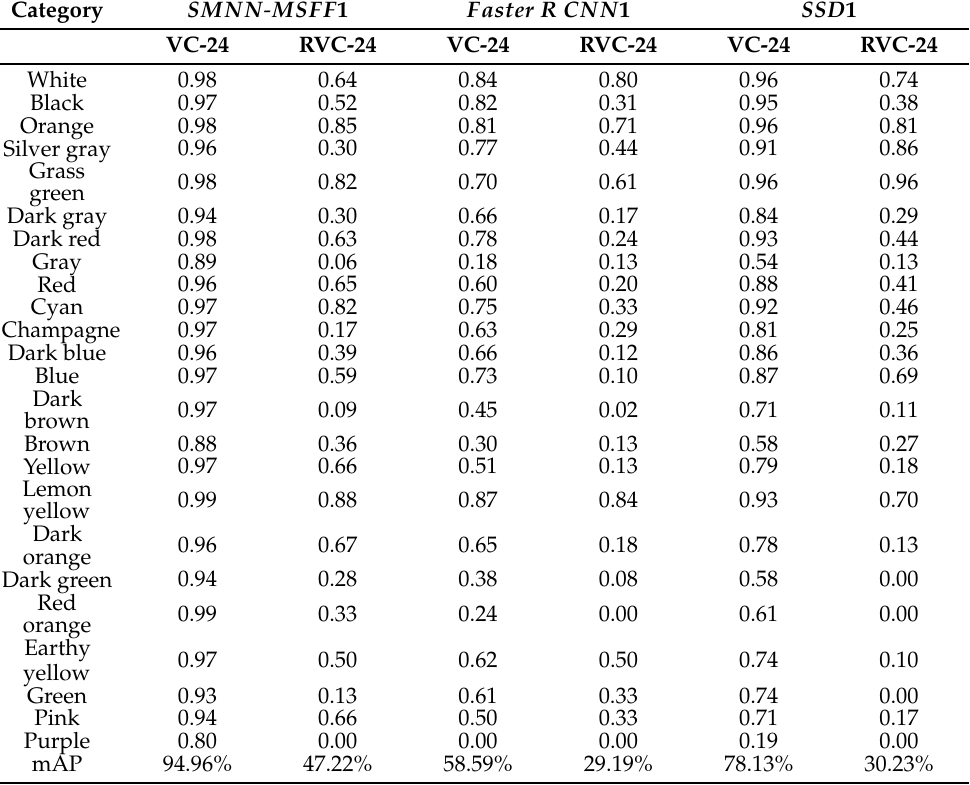
Figure 19. Object detection test results on rain images from Rain Vehicle Color -24. ( a , d ) Rain image; ( b , c ) object detection test result with SSD 1 and Faster R CNN 1, which are trained on Vehicle Color -24; ( e , f ) object detection test result with SSD 2 and Faster R CNN 2, which are trained on the Rain Vehicle Color -24. Table 3. Comparison of the average accuracy of each category of object detection algorithms on Vehicle Color -24 and Rain Vehicle Color -24 test sets. All object detection algorithms are trained on Vehicle Color